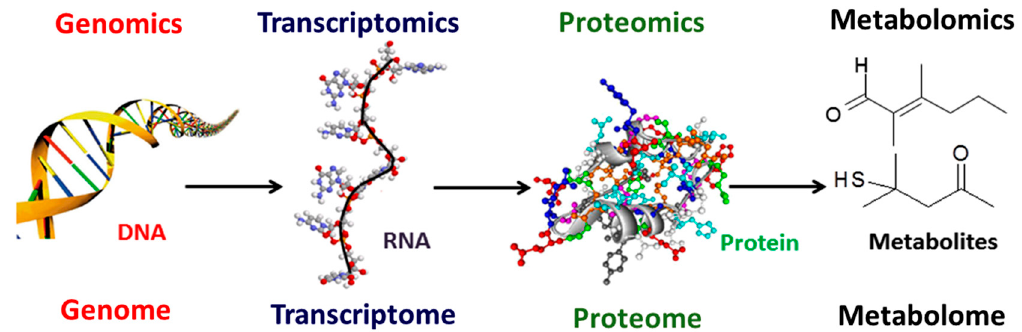
Figure 1. The hierarchy of “omics” technologies. The post-genomics approaches (e.g., transcriptomics, proteomics, and metabolomics) together can provide comprehensive information and better understanding about the biological system (adopted from Pinu [13]).